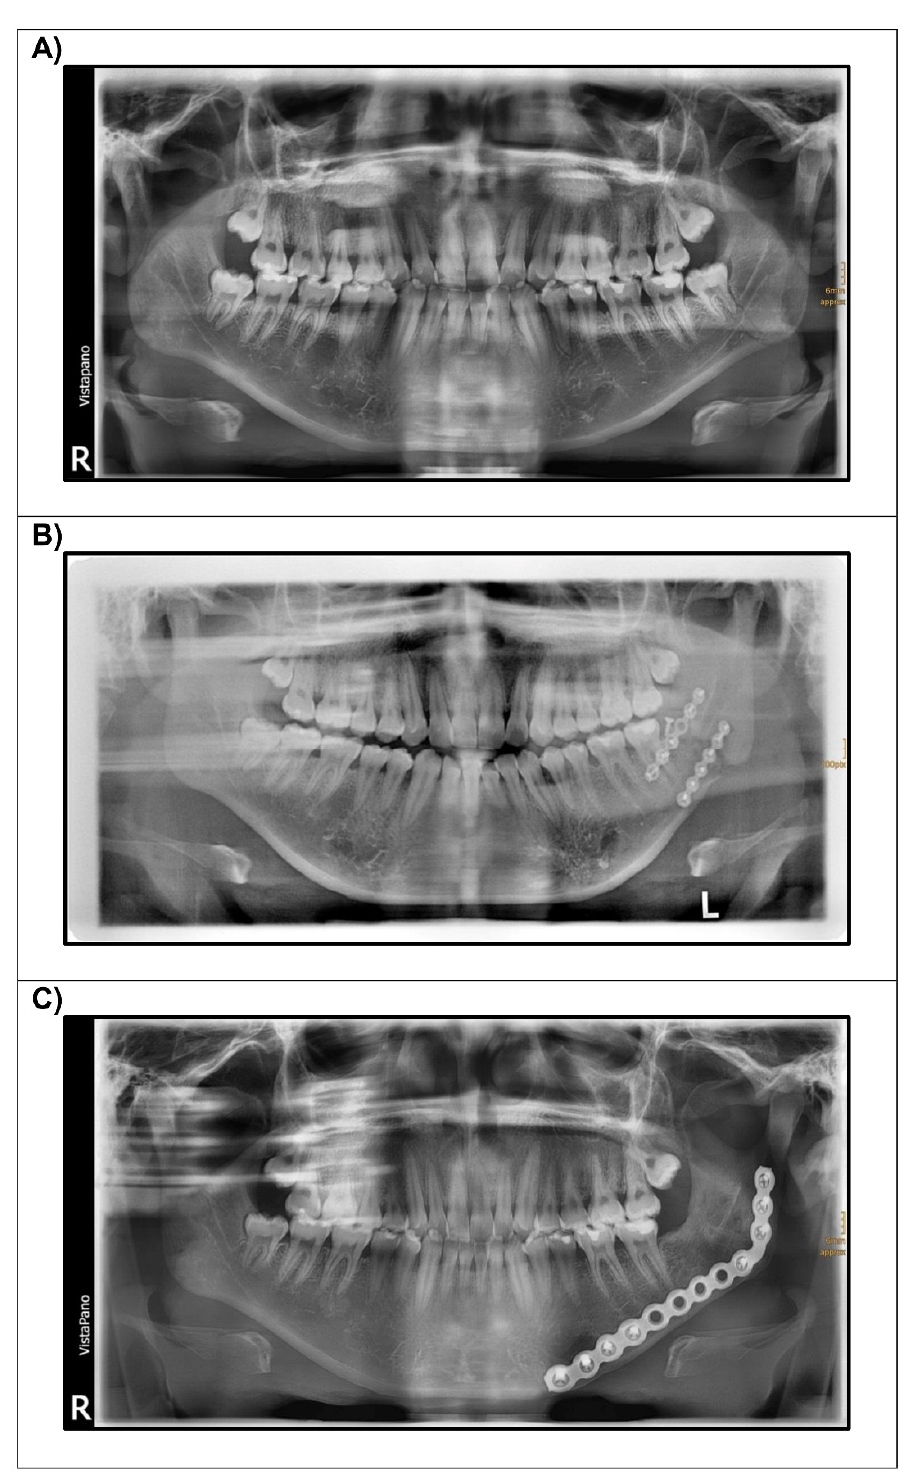
Figure 1. Exemplary patient case of secondary reconstruction using a 2.8 mm reconstruction plate after failure of primary fracture fixation with two miniplates (panoramic radiographs ( A ) after trauma; ( B ) after reconstruction with two miniplates; ( C ) after secondary reconstruction using a reconstruction plate).